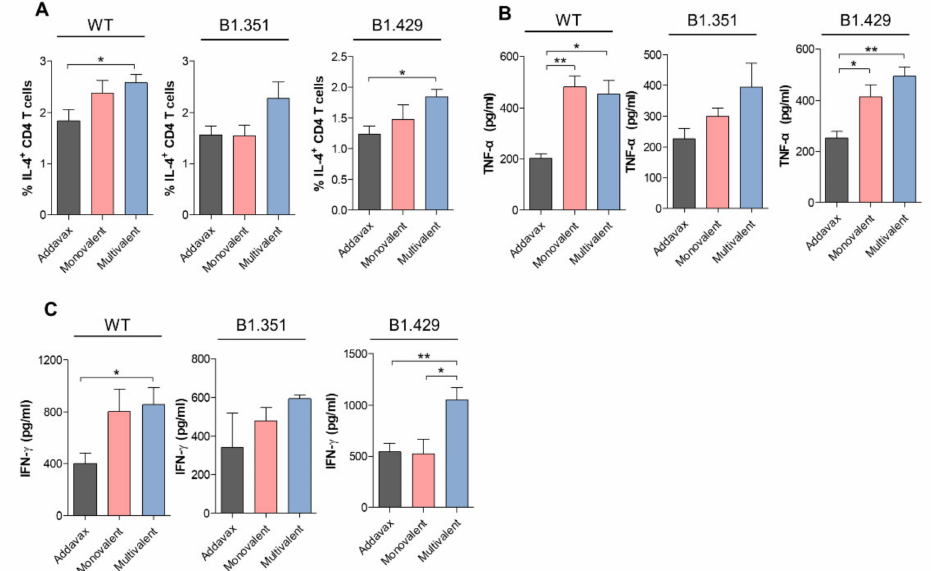
Figure 3. SARS-CoV-2 WT and variant-specific immune responses induced by multivalent spike-HPF vaccine. Immune cells were stimulated with peptide pools corresponding to the fragments of WT, B1.315, and B1.429. ( A ) The proportion of IL-4-producing SARS-CoV-2 WT and variant-specific CD4 + T cells, indicating that Th2 responses were detected using flow cytometry. ( B , C ) Cytokine secretion from peptide-stimulated CD4 + T cells was determined by ELISA. ( B ) TNF- α and ( C ) IFN γ , indicating that Th1 responses were evaluated. Statistical comparisons were performed using a Student t-test, and statistically significant differences were presented as follows: p < 0.05 * or p < 0.01